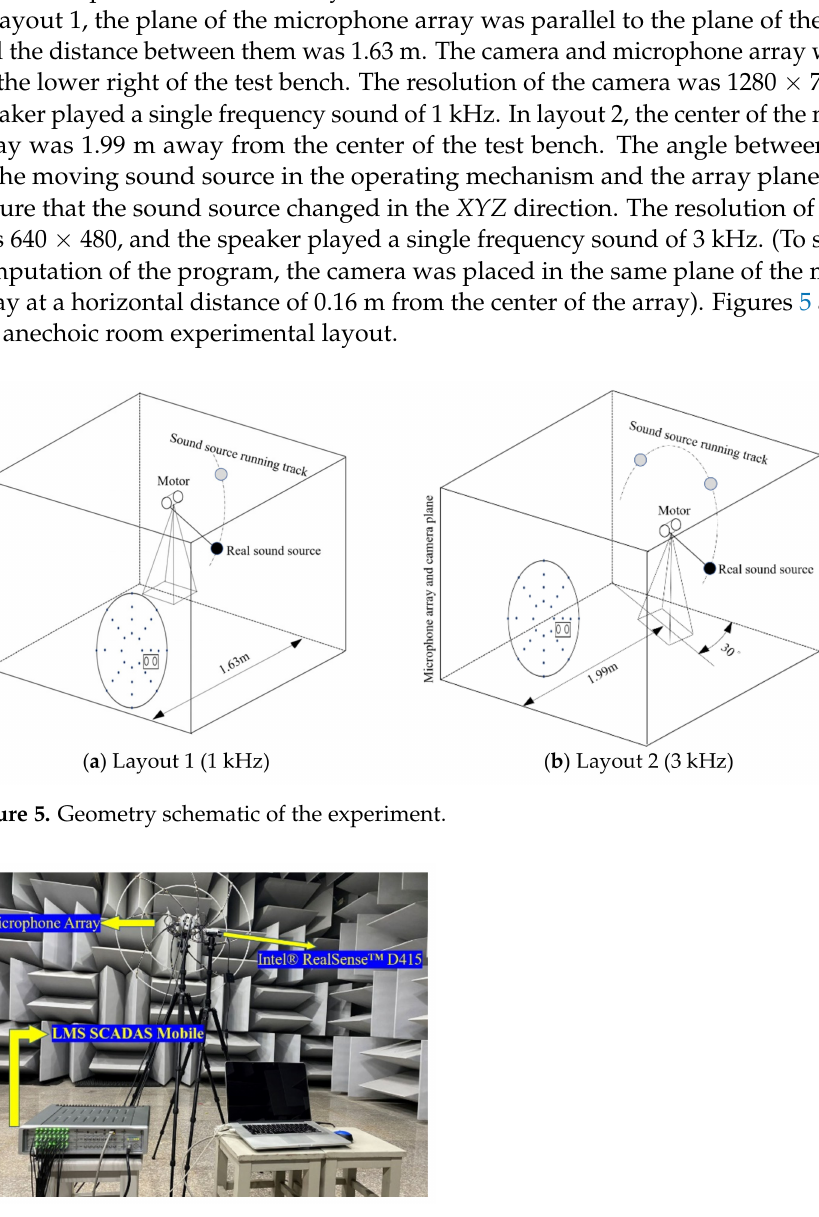
Figure 6. Experimental